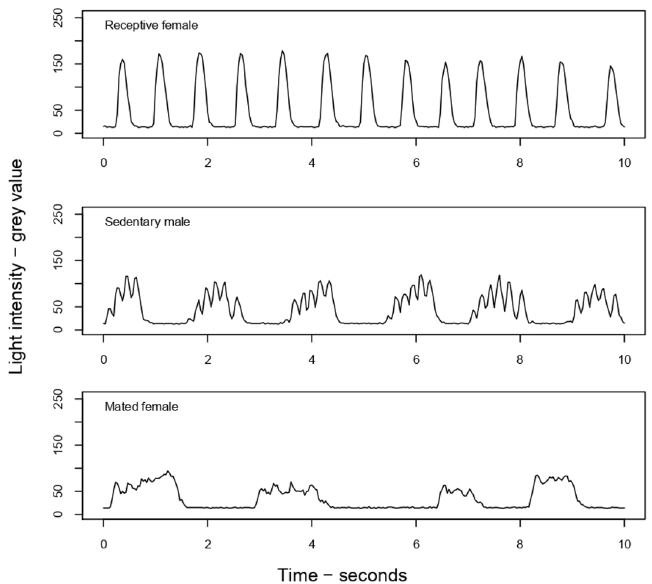
Figure 1. Examples of the waveforms from a receptive female (above), a sedentary male (middle), and a mated female (bottom) of adult A. lateralis recorded in the natural